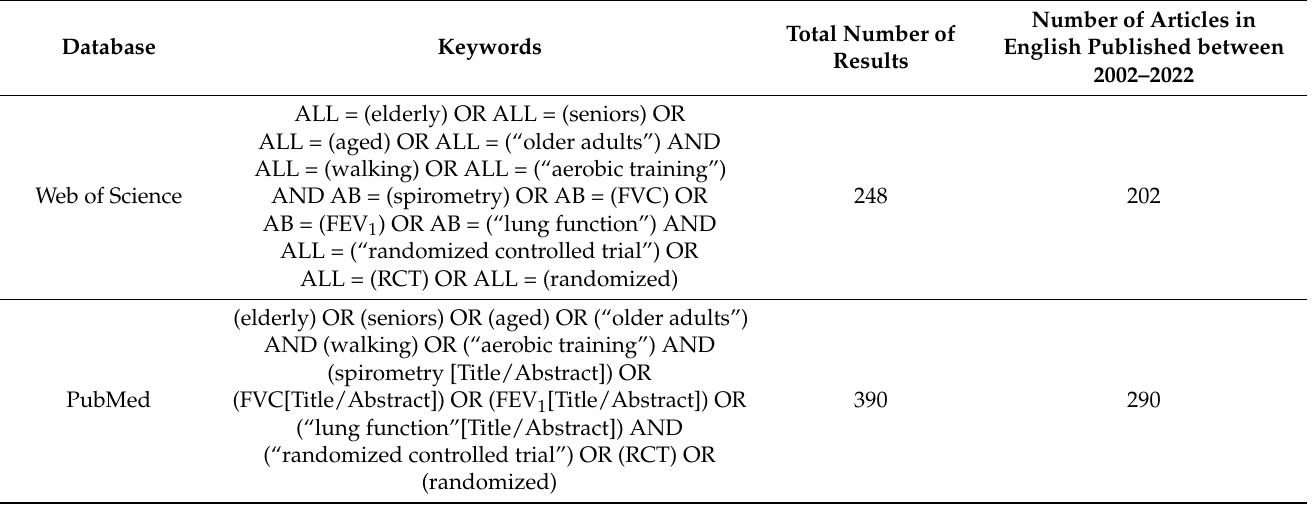
Table 1. The PRISMA